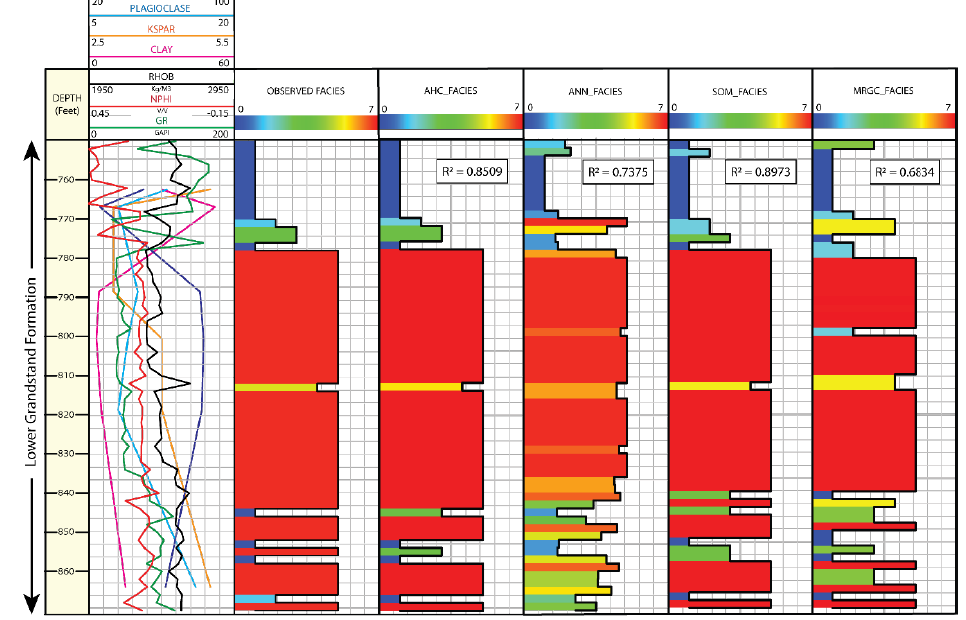
Figure 3. Comparison of observed vs. predicted lithofacies in Umiat 18.